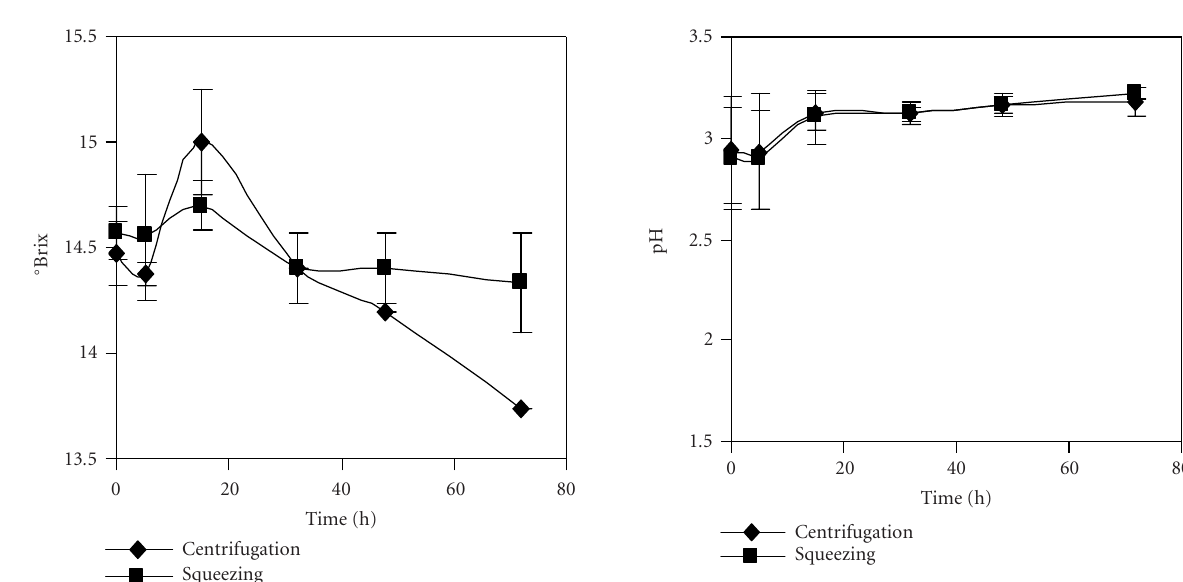
Figure 8. Evolution of ◦ Brix of pomegranate juices obtained by centrifugation of seeds and by the squeezing of fruit halves with an electric lemon squeezer and stored for 72 hours at 4 ◦ C. Bars represent standard deviation of 4 replications.